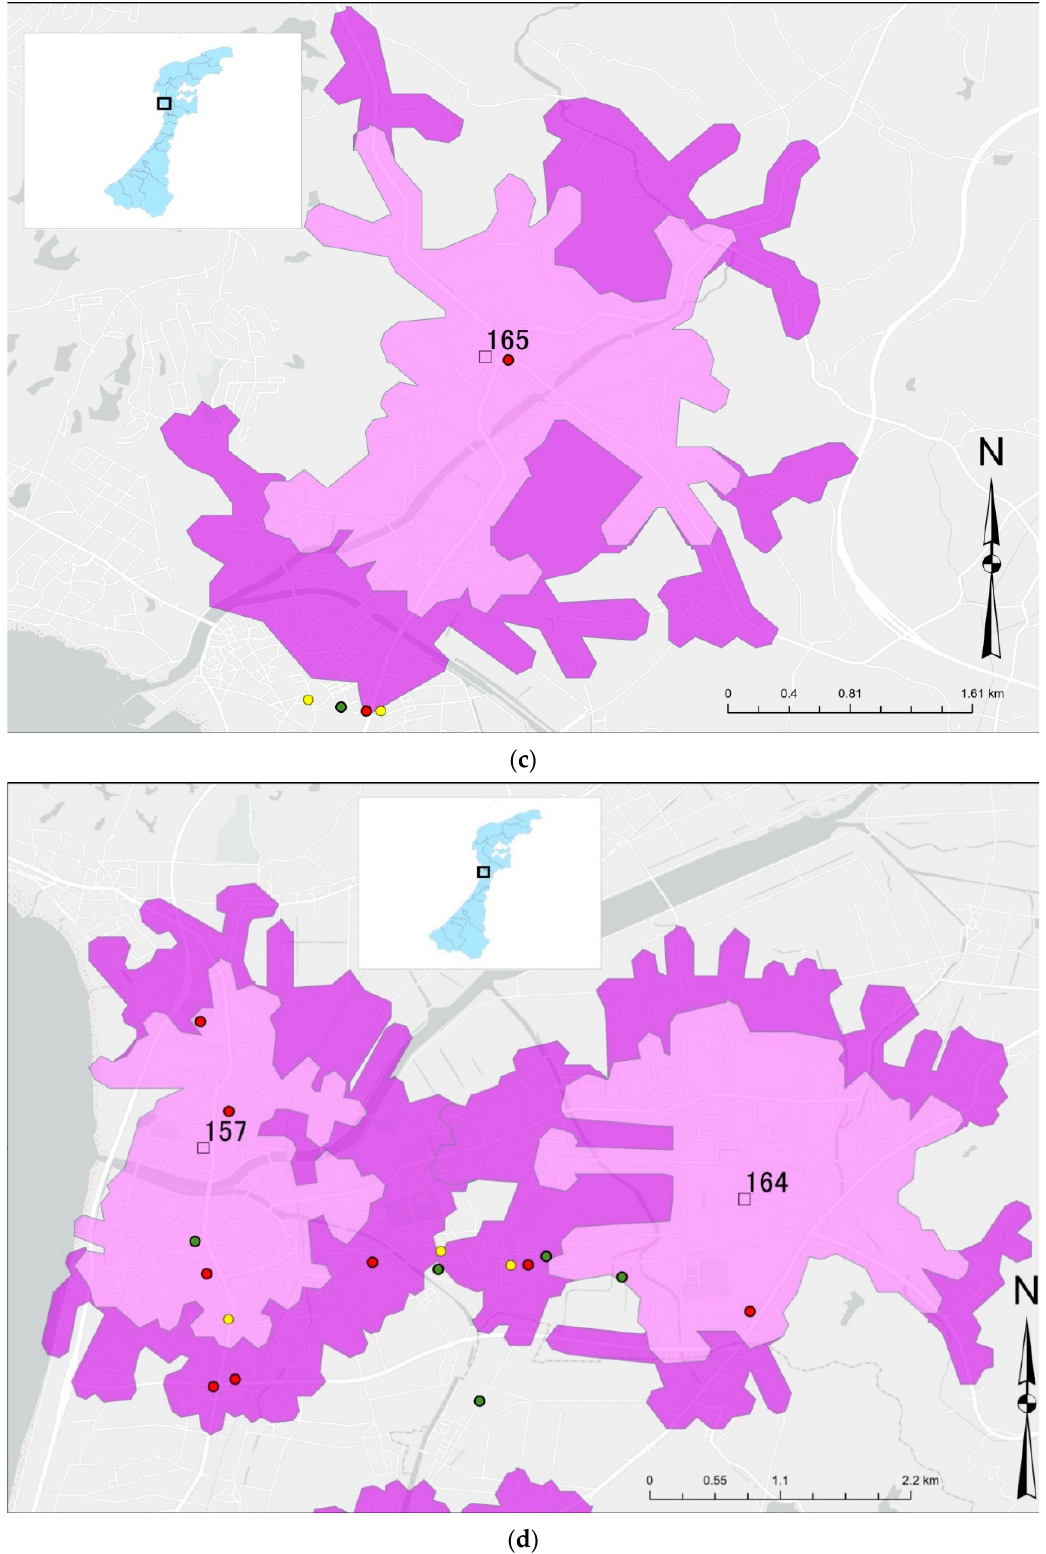
Figure 3. ( a ) Geographical distribution of GHs and SPs in ELAs in Anamizu Town. ( b ) Geographical distribution of GHs and SPs in ELAs in Nanao City (For legends, see Figure 3a). ( c ) Geographical distribution of GHs and SPs in ELAs in Shika Town (For legends, see Figure 3a). ( d ) Geographical distribution of GHs and SPs in ELAs in Hakui City (For legends, see Figure 3a).